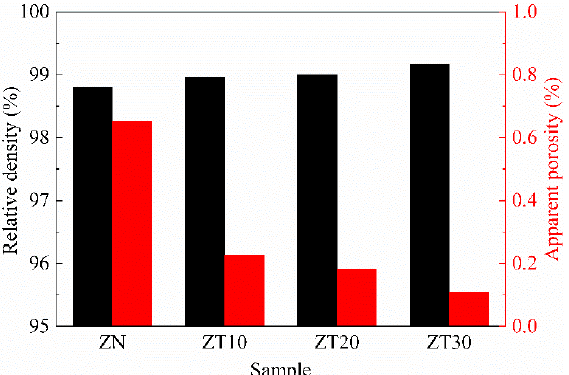
Figure 7. The relative density and apparent porosity of the sintered